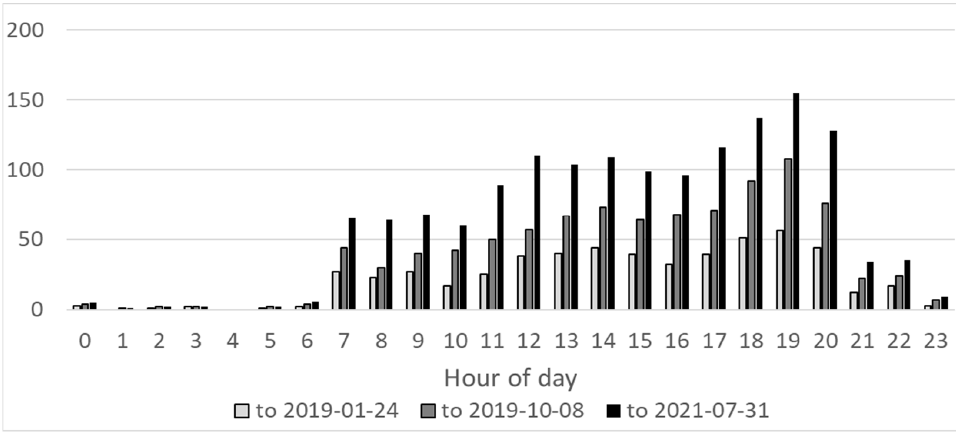
Figure 7. Frequency distribution of stream stage observations by hour of day shows limited activity after 11 P.M. and prior to 7 A.M. Patterns are consistent over separate cumulative time periods. Most participants (445 participants, or 75%) contributed stage observations a single time during the study period, while eight participants (1%) were considered regulars by contributing more than 20 observations. Only one “champion”, with contributions in excess of 100 observations, was identified (Figure 9). The distribution of contributions by participant closely followed the pattern observed in the CrowdHydrology project